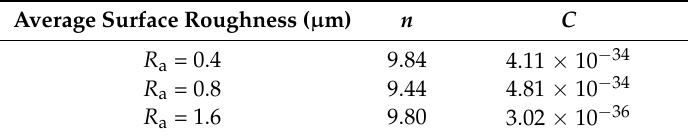
Table 7. Material constants C and n in Equation (11) with different average surface